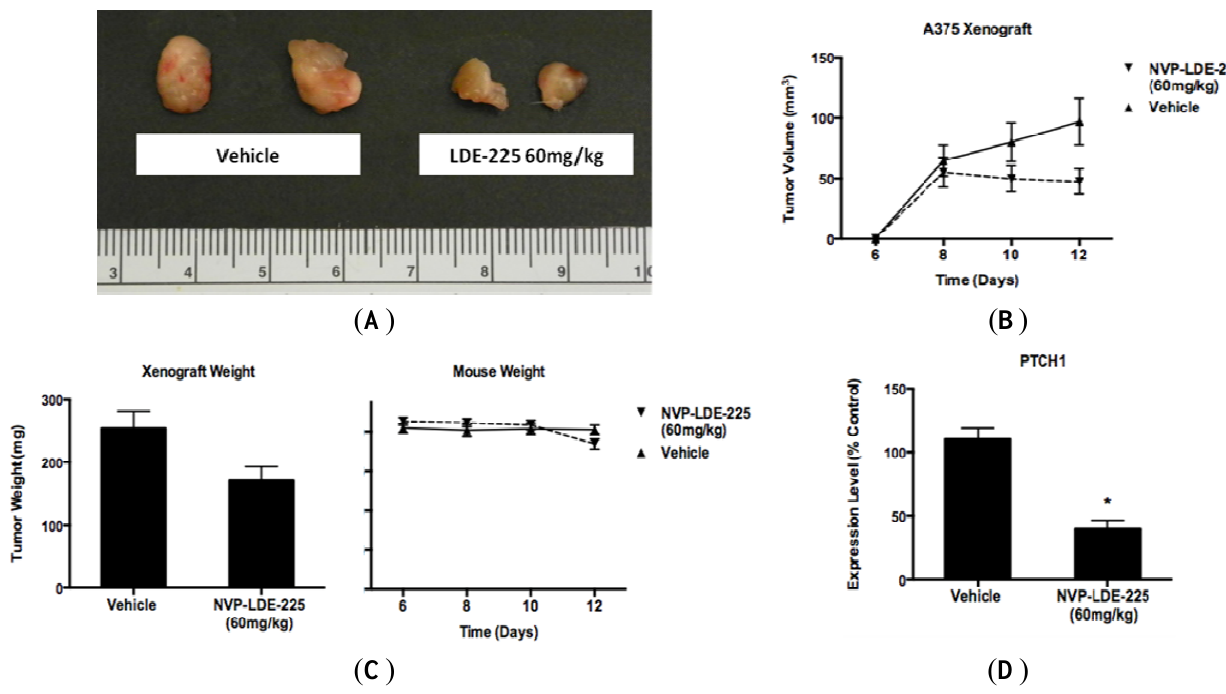
Figure 7. NVP- LDE-225 60 mg/kg inhibits melanoma cell proliferation in vivo . ( A ) One week of daily NVP-LDE-225 60 mg/kg administered by oral gavage to an A375 xenograft model in NOG mice inhibits melanoma growth better than vehicle. ( B – C ) Tumors in NVP-LDE-225 treated mice (n = 6) are of lower volume ( p = 0.103) and weight ( p = 0.0979) than the tumors in vehicle treated mice (n = 7). The mice in the vehicle and LDE-225 treated groups are of similar weight throughout the duration of treatment ( p = 0.691). ( D ) NVP-LDE-225 inhibits the hedgehog pathway as measured by decreased PTCH1 transcript in the tumors of NVP-LDE-225 treated mice as compared to the transcript levels in the tumors of control treated mice, as measured by qRT-PCR ( * , p < 0.003). In B–C, values represent the mean ± standard deviation of at least 6 animals per treatment group. In D, the values represent the mean ± standard deviation of triplicate qPCRs from the tumors of three mice from each treatment